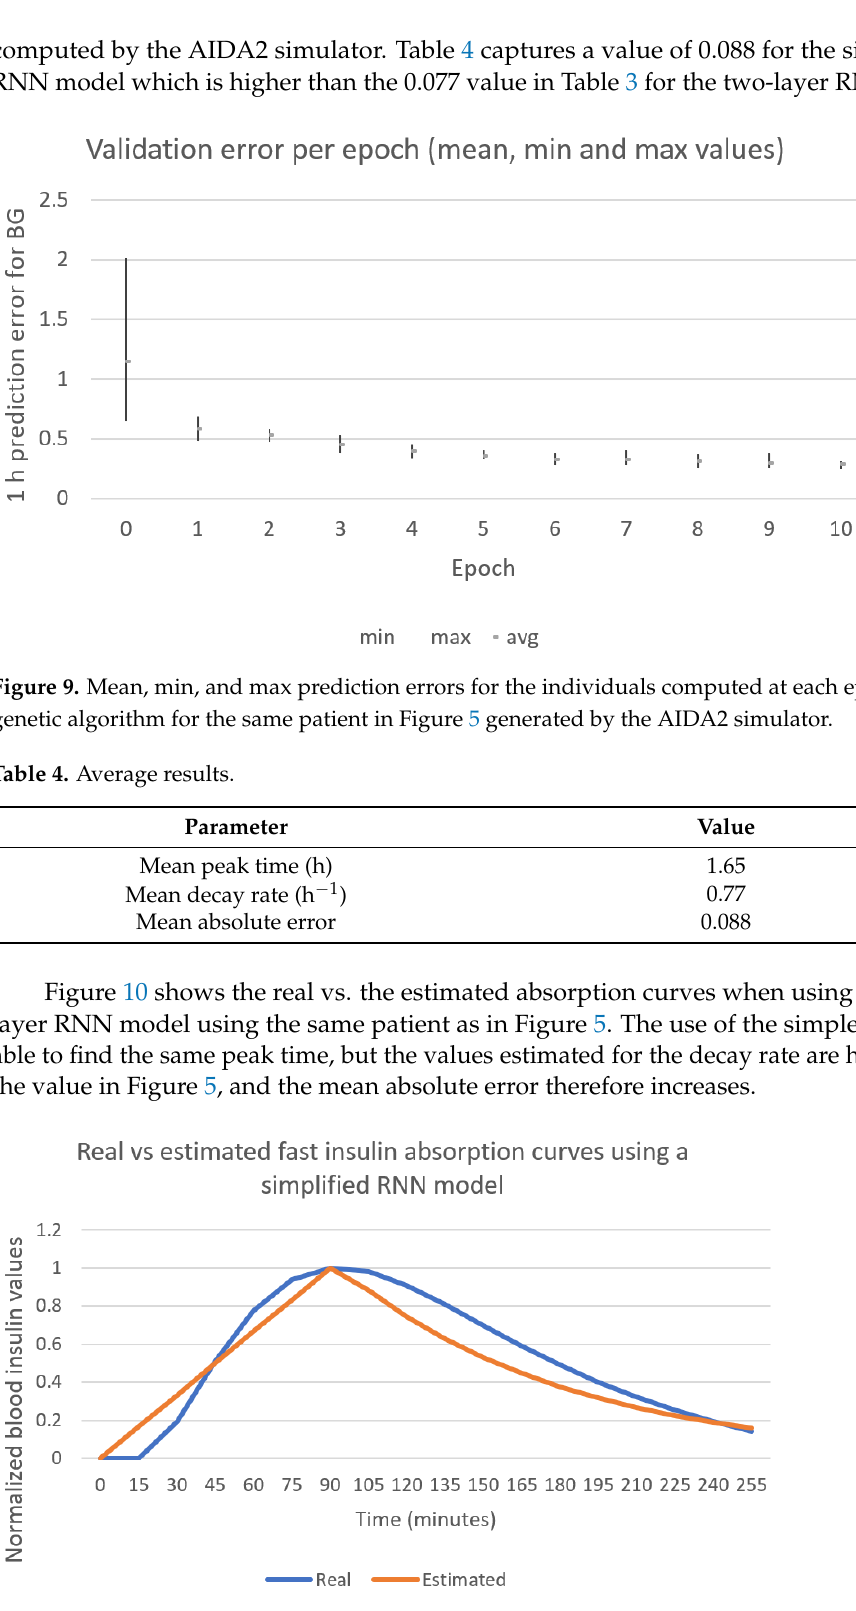
Figure 10. Real vs. estimated fast insulin curves using a single LSTM layer RNN.